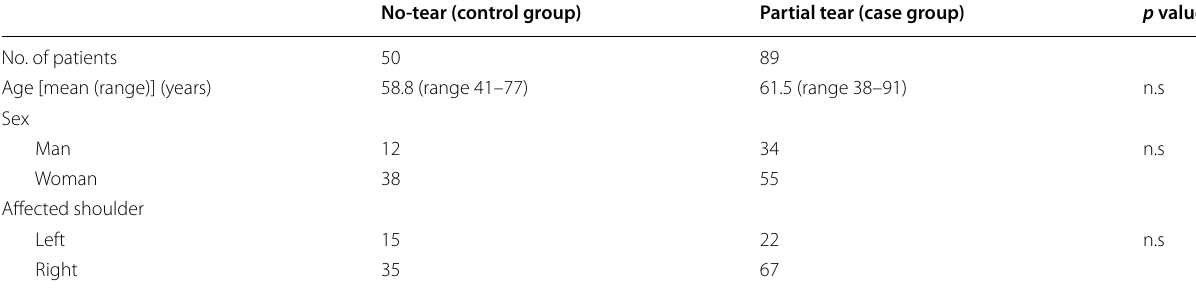
Table 1 Comparison of patient demographic description between the case group and control group